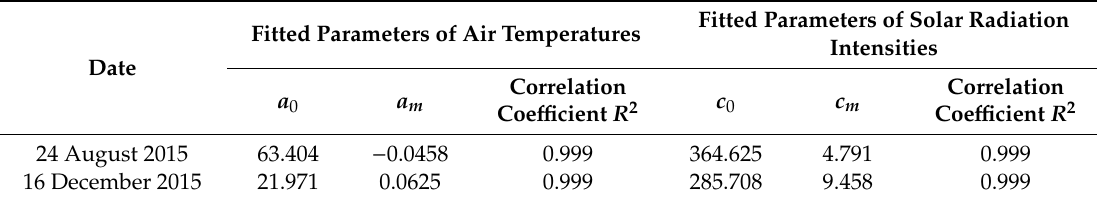
Table 2. Fitted parameters of the air temperatures and solar radiation intensities. Fitted Parameters of Solar Radiation Fitted Parameters of Air Temperatures Intensities Correlation Correlation a 0 a m c 0 c m Coe ffi cient R 2 Coe ffi cient R 2